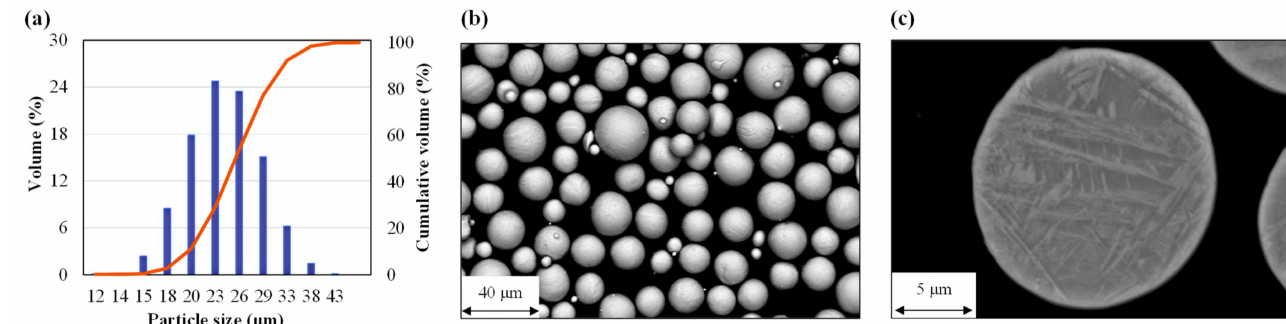
Figure 1. Characteristics of the gas-atomized Ti6Al4V powder: ( a ) size distribution, ( b ) morphology, and ( c ) microstruc- ture [1,20].